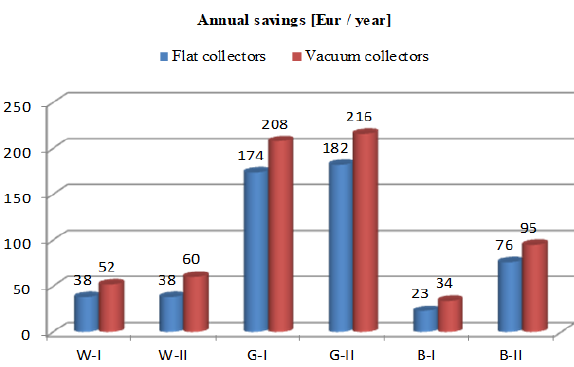
Figure 6: Annual savings from the use of solar collectors. Source: Own